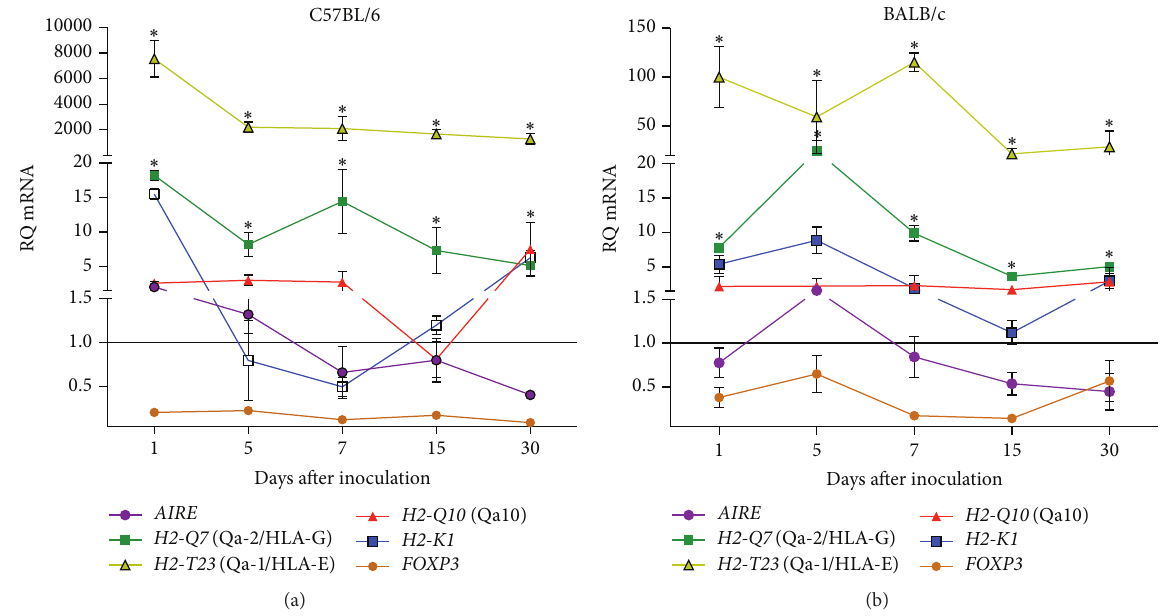
Figure4:Transcriptionalprofilesofimmunomodulatorygenesinthymusof(a)C57BL/6and(b)BALB/cmiceinoculatedwith10.000LD 50 of YFV17D. RQ = relative quantification representative of geometric mean values of 2 −ΔΔ Ct . RQ values expressed as fold change relative to control groupvalues(baseline=1).StatisticalanalysiswasperformedusingthenonparametrictestKruskal-WallisDunn’smultiplecomparison.Values close to the level of significance ( 𝑃 < 0.05 ) are marked with ∗